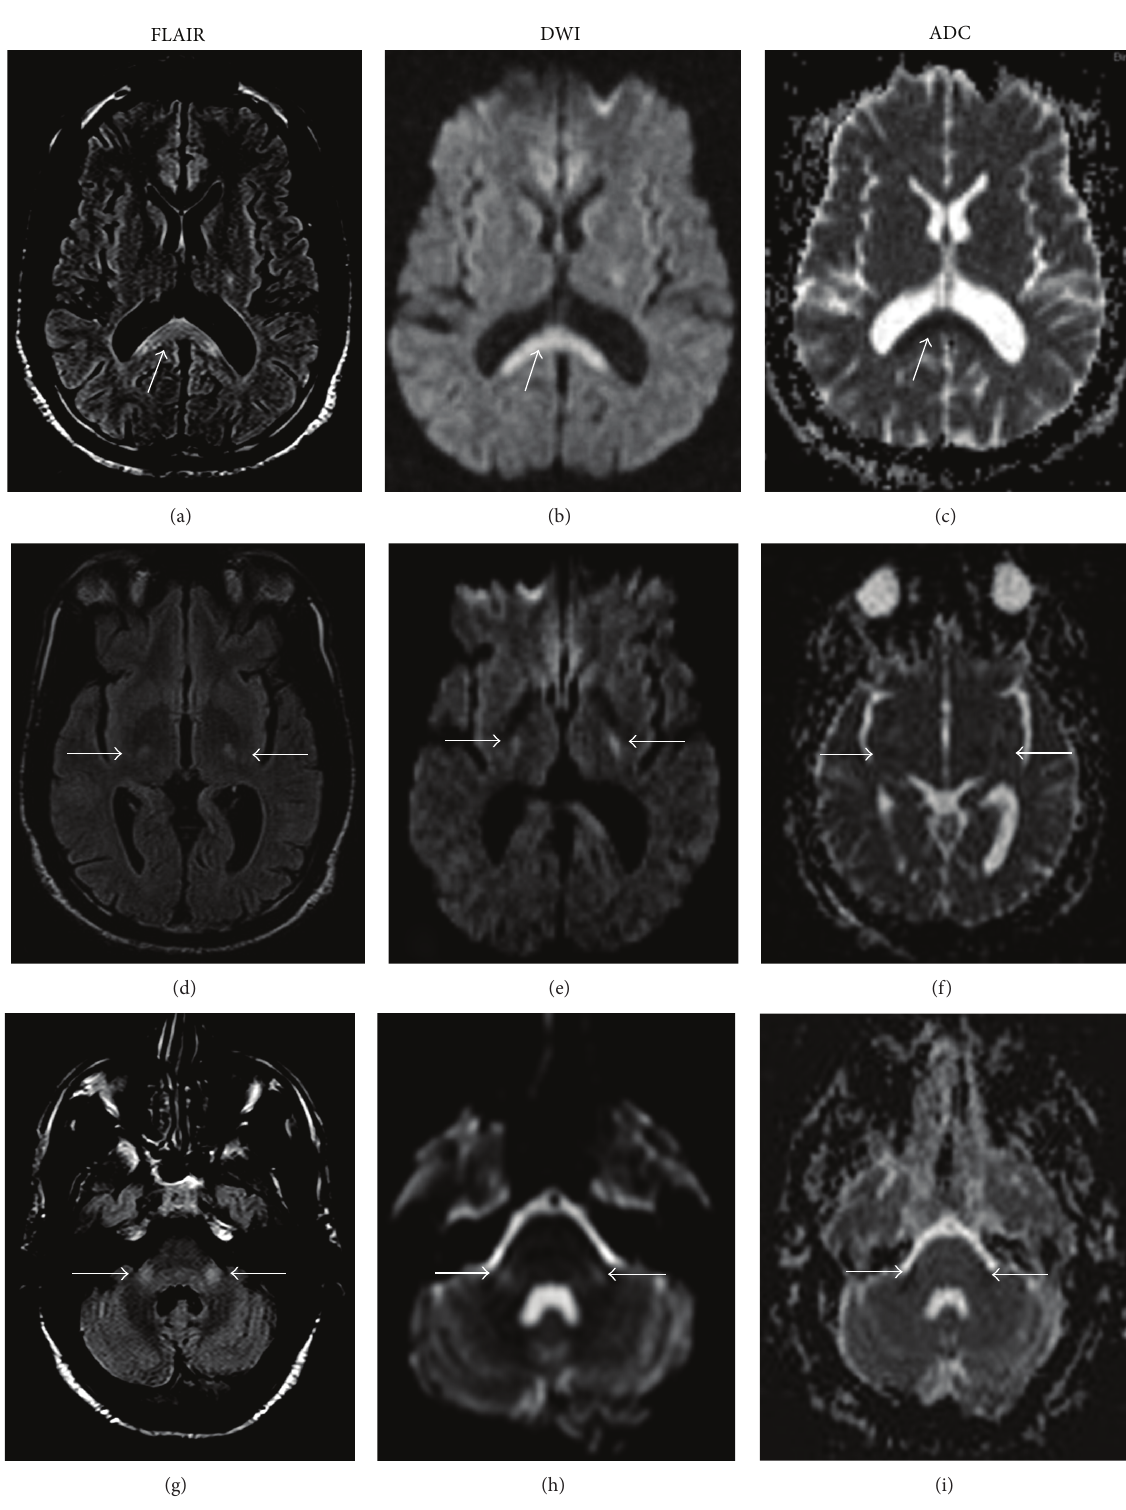
Figure 1: Brain MRI of fluid attenuated inversion recovery (FLAIR), diffusion-weighted imaging (DWI), and apparent diffusion coefficient(ADC) images showing altered attenuation (arrow) in splenium of corpus callosum (a–c), bilateral posterior limbs of internal capsule (d–f), and bilateral brachium ponti